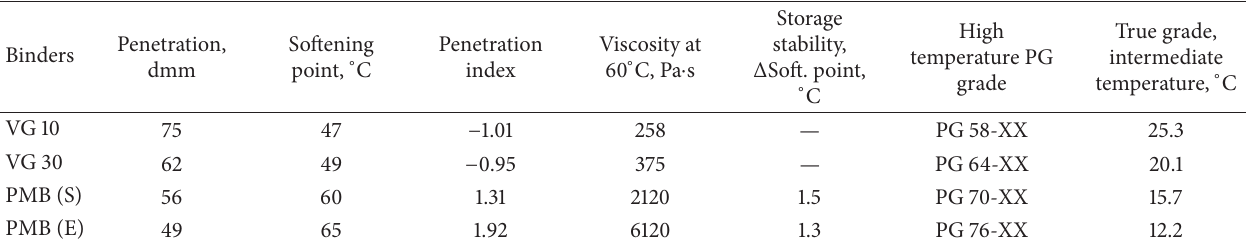
Table 1: Conventional properties of binders used in the study.